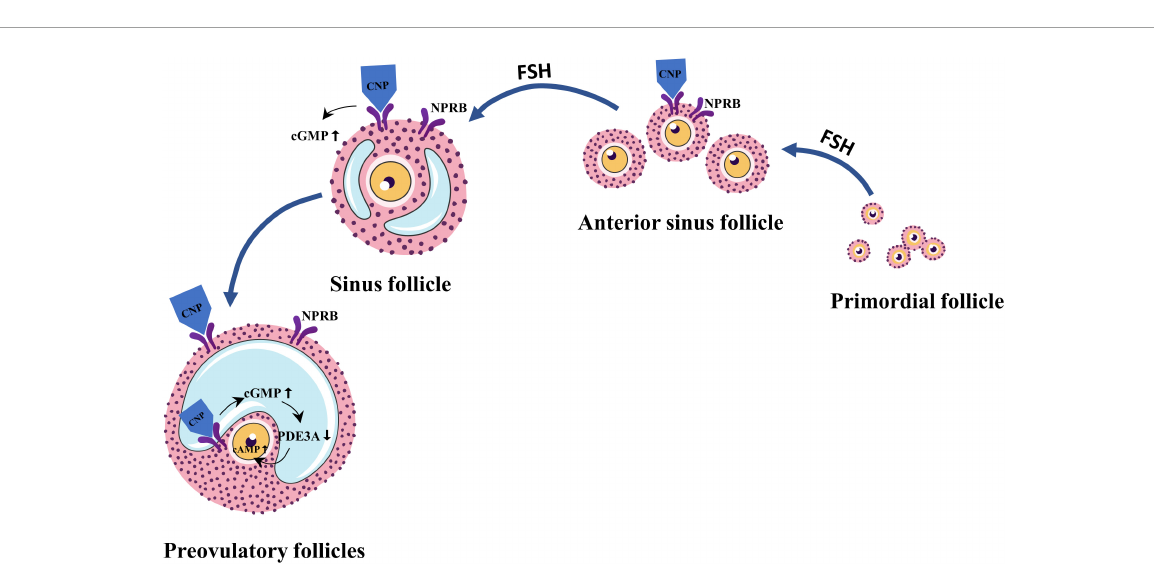
lead to failure of follicle development in the late reproductive phase (12), which may contribute to the fact that in ROS patients, during repeated ovulation stimulation, even when follicles develop, they reach atresia occurs before dominance.